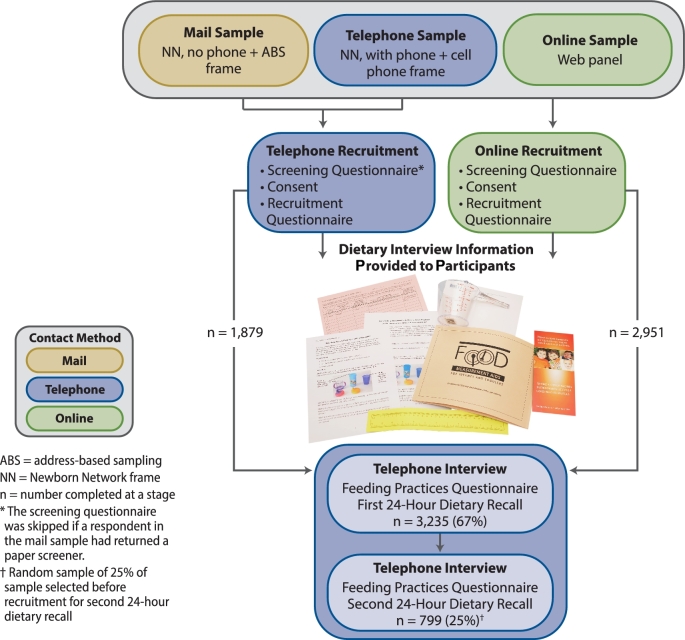
Data collection schematic for the Feeding Infants and Toddlers Study 2016.